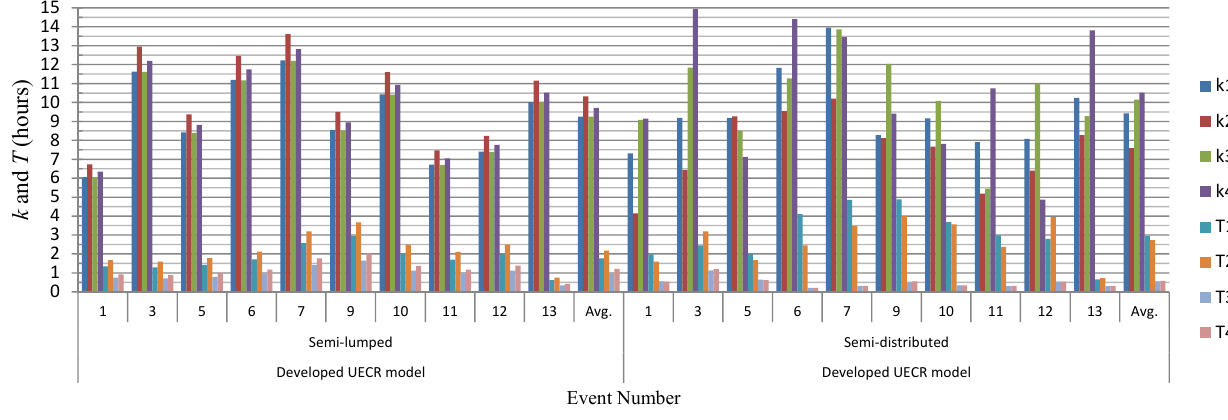
Figure 8. Values of k and T parameters in the modified GUHN model.